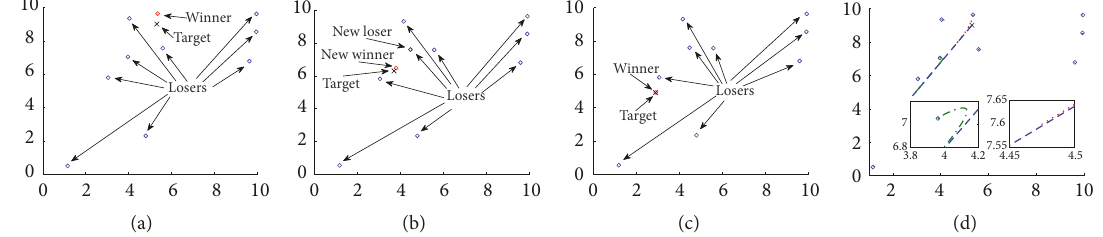
Figure 7: ( Phase 1 ) With 𝑘 = 1 , snapshots for distributed coordination model (19) with limited communications for tracking the moving target and the corresponding tracking trajectories, where initial locations of mobile robots and the moving target are randomly generated. In this sense, at each time instant, ten mobile robots compete with each other for tracking the moving target, and only one of them with the minimum distance from the moving target (the winner) is activated to track while the rest ones (the losers) keep unmoved. At 𝑡 ≈ 0.5 s, as the moving target approaches to one of the losers, the winner at the initial time fails in the competition and becomes a loser marked in black line. As a continuator, the new winner marked in red line begins to track the moving target. (a) Snapshots at 𝑡 = 0 s. (b) Snapshots at 𝑡 = 1